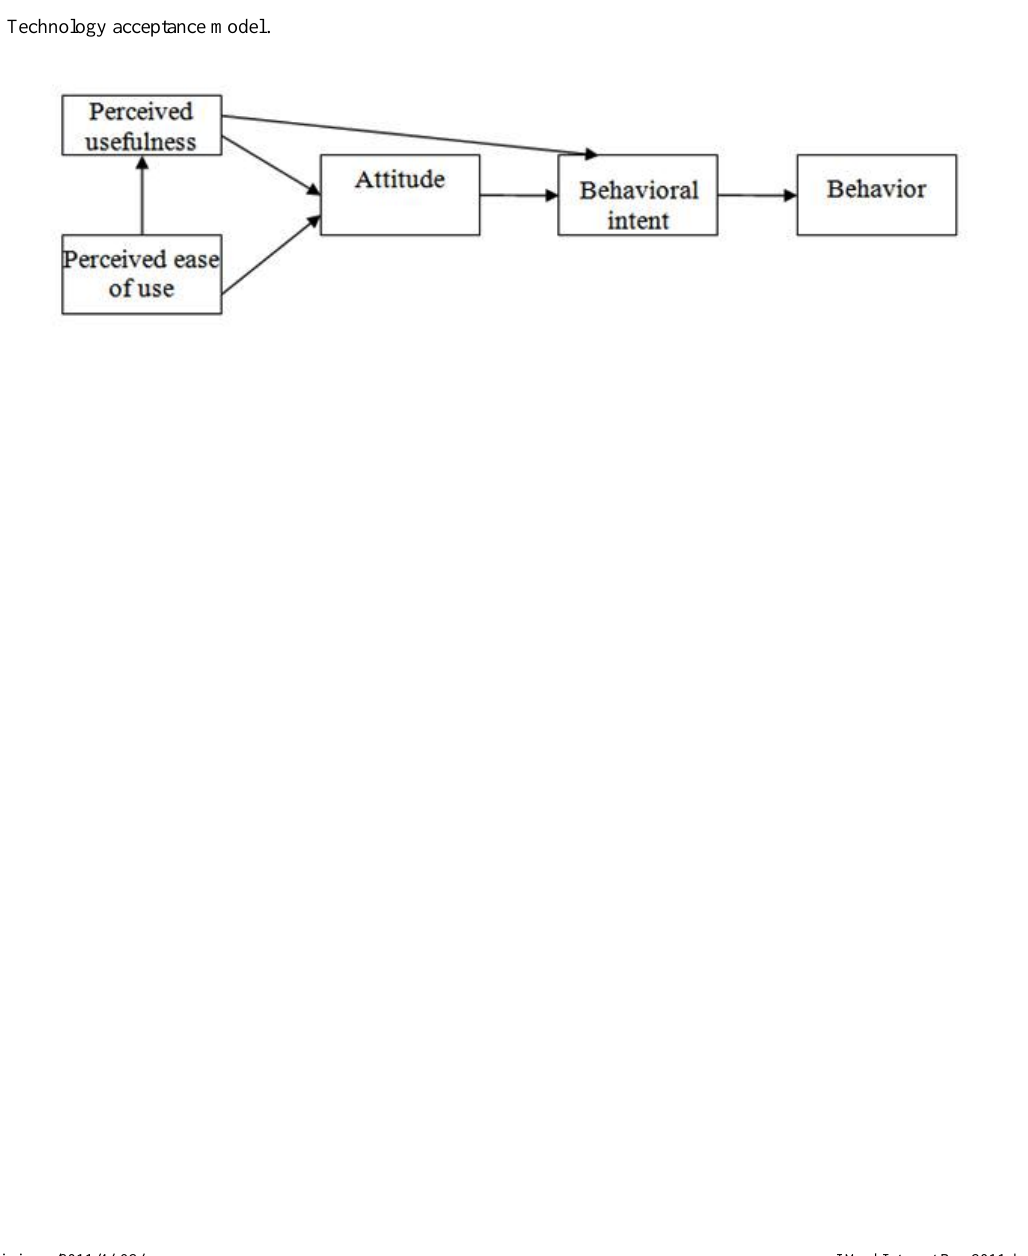
Figure 3. Technology acceptance